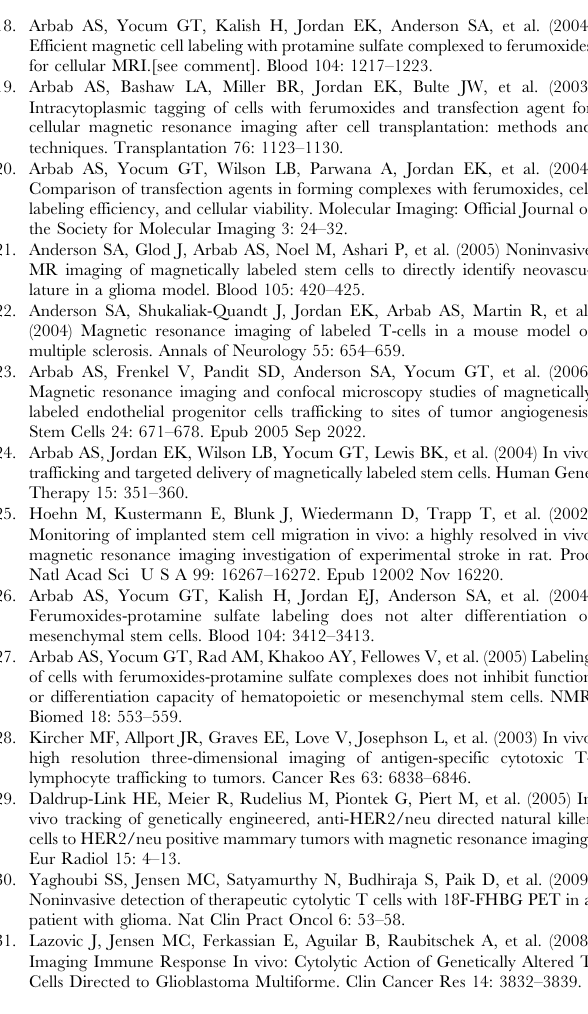
the boxed areas. Figure S4B: Representative case of MBA-MD- 231 tumor. Gradient echo (GRE) MRI with two different echo times (TE), 10 ms (A) and 20 ms (B), shows no definite low signal intensity areas along the peripheral parts of the subcutaneously implanted MBA-MD-231 breast cancer tumor. However, large low signal intensity areas were seen within the tumors (Arrows on A and B), which are thought to be due to hemorrhage. DAB enhanced Prussian blue staining shows no definite iron positive cells at the peripheral parts (C, D) of the tumor, however, there are multiple areas of hemorrhagic foci (RBC) seen in the deeper parts of the tumor (E, arrows). A few iron positive cells, that could possibly be injected CTLs, are seen in the deeper part of the tumor (E, arrow head). (C) Magnification 10x. (D and E) Magnification 25x. Found at: doi:10.1371/journal.pone.0009365.s005 (7.41 MB TIF) Figure S5 Detection of smaller U251 tumor. Magnetically labeled CTLs were injected intravenously in rats bearing U251 implanted tumor (n= 3) on day 7 after the implantation. Both T2- weighted (T2WI) and T2*-weighted (T2*WI) images were acquired on day 3 and 7 after IV administration of CTLs. Following the last MRI, animals were euthanized and their brains including tumors were collected after perfusion and prepared for histochemical analysis. Images from representative experiment demonstrate migration and accumulation of administered CTLs in